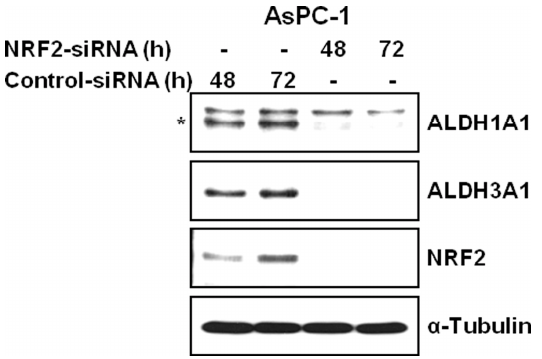
Figure 4. NRF2 knockdown inhibits the protein expression of ALDH1A1 and ALDH3A1. AsPC-1 cells transfected with NRF2-siRNA or control-siRNA for 48 h or 72 h were subjected to western blot analysis using indicated antibodies. Anti- α -Tubulin antibody was used as a loading and transfer control.